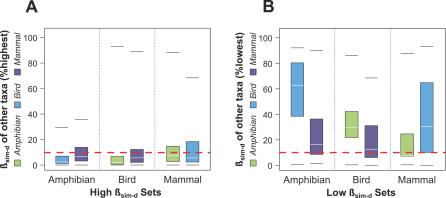
Levels of Beta-Diversity for Vertebrate Taxa within Areas of High and Low Beta-Diversity of Amphibians, Birds, and MammalsPercentage sets of the highest (A) and lowest (B) 2.5% of beta-diversity (βsim-d) grid cells for one taxon (x-axis) contain a range of βsim-d levels for the other taxa (y-axis), as shown by the box plots (white lines within boxes indicate the median; top and bottom box edges indicate first and third quartiles; black lines indicate minimum and maximum percentage rank of βsim-d). The red dashed line indicates the highest or lowest 10% of βsim-d.